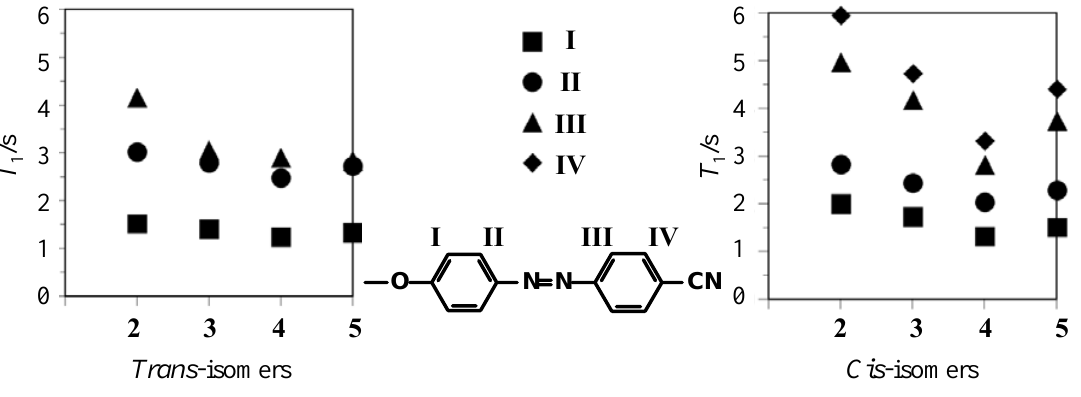
Trans -isomers Cis